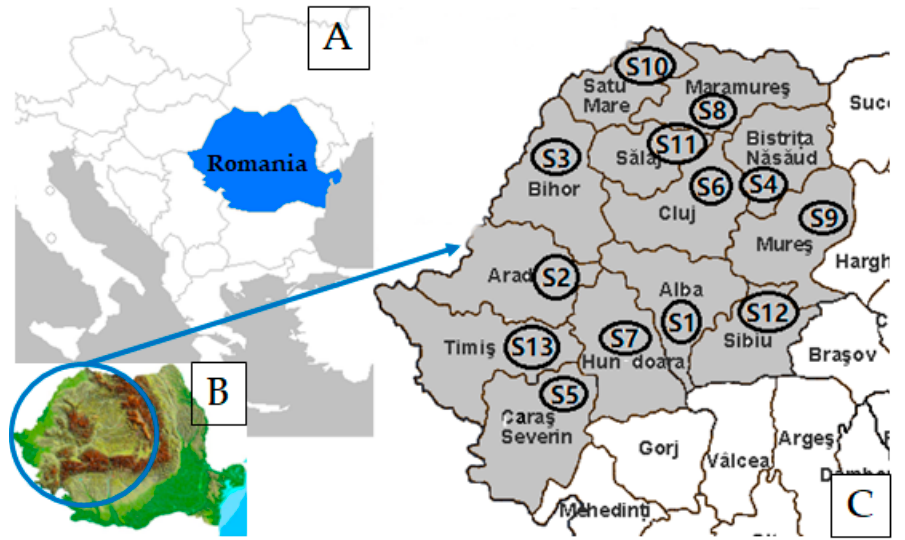
Figure 6. Romania’s position on the map of Europe ( A ); Geographical map of Romania, highlighting the sampling area ( B ); identification of the 13 counties for sampling ( C ).